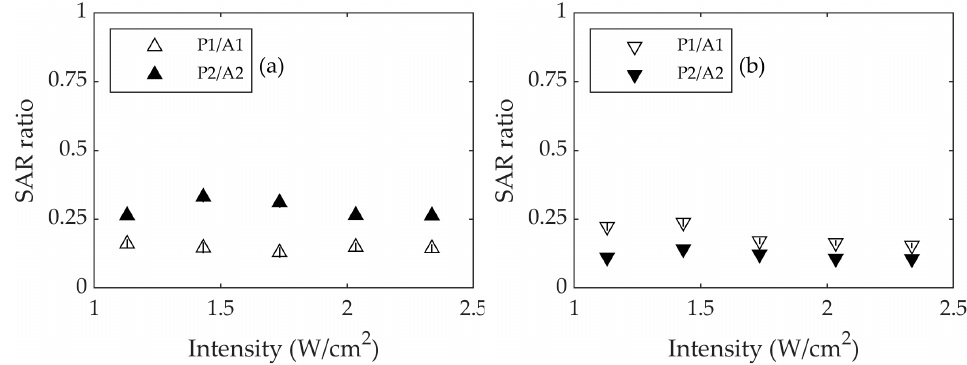
Figure 9. Ratio SAR iron oxide /SAR IRA 980B using lasers at ( a ) 800 nm and ( b ) 1053 nm. Open triangles stand for S 1 (1300 μ m), and solid triangles stand for S 2 (1900 μ m). A 1 and A 2 are the laser spot areas corresponding to S 1 and S 2. Errors are represented as vertical bars.